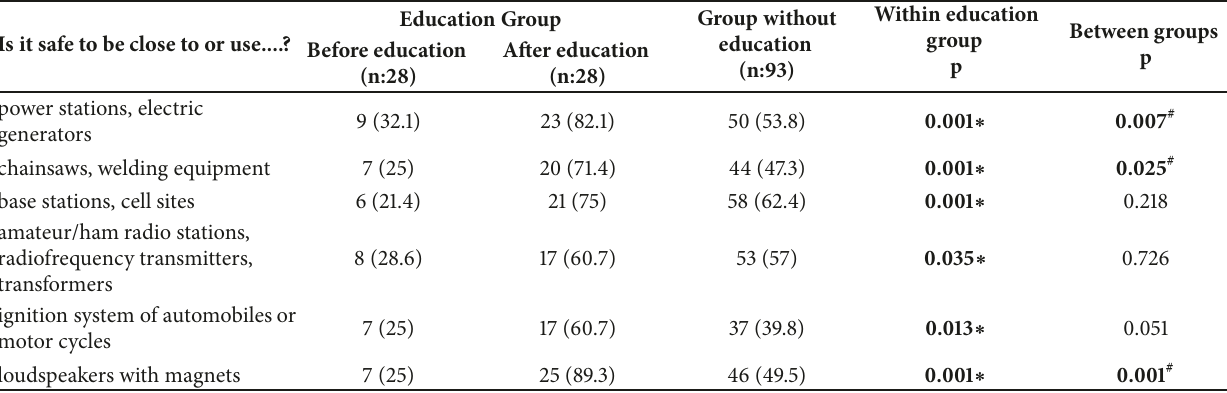
Table 5: Correct responses to questions on harmful equipment for electromagnetic interference with cardiac implantable electronic devices. Is it safe to be close to or